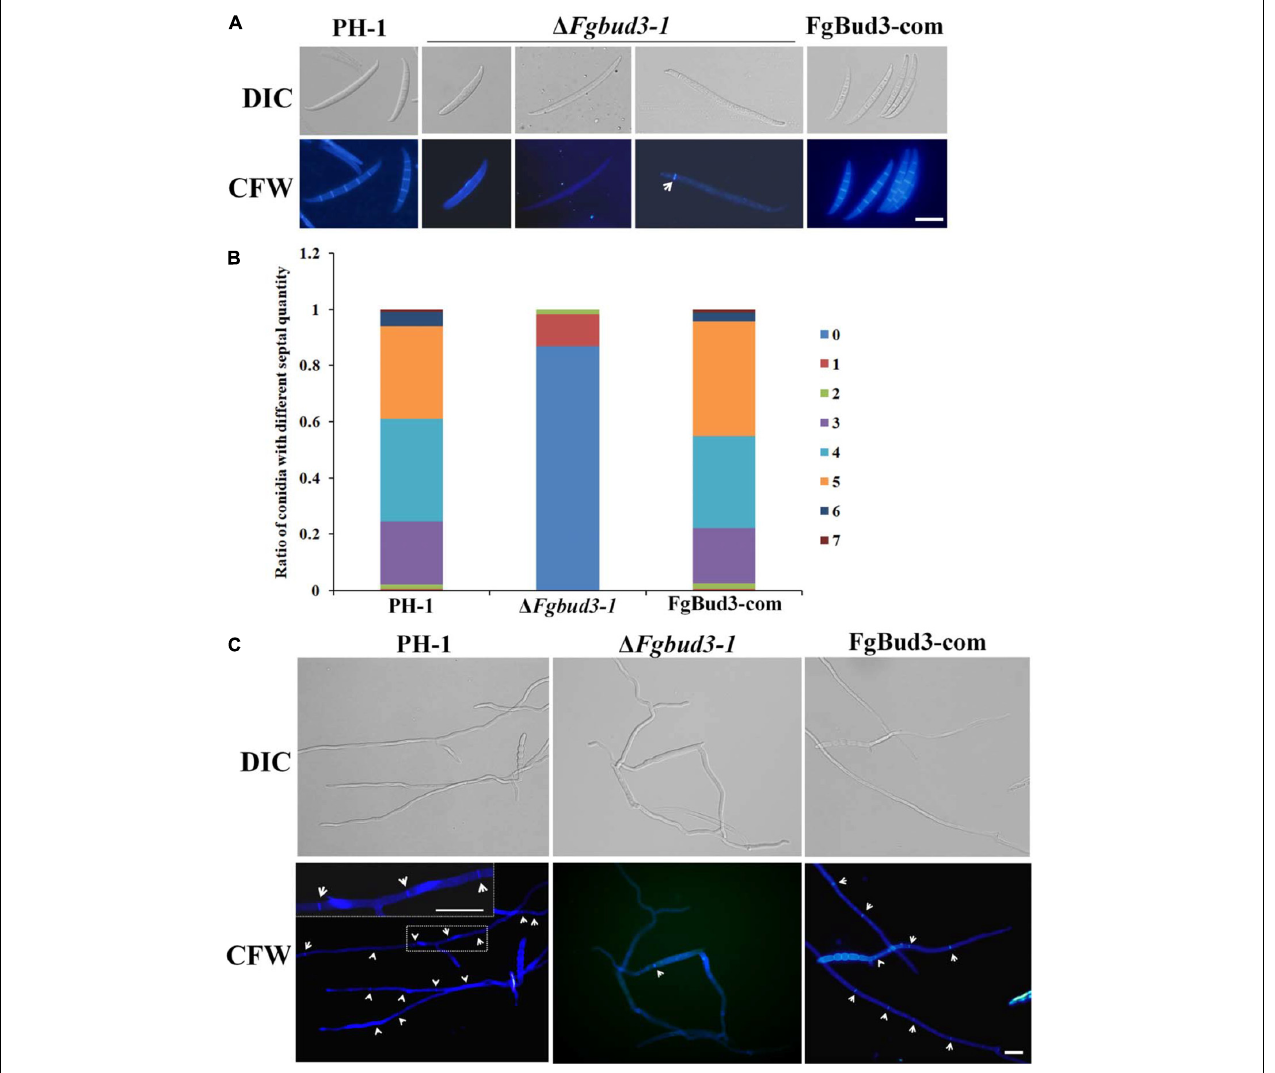
FIGURE 3 | The septum defective phenotype of the FgBUD3 deletion mutant. (A) Conidia of PH-1, (cid:49) Fgbud3-1 and FgBud3-com were stained with 1 µ g/ml CFW and examined by microscopy under DIC or UV light. (B) Ratio of conidia with different septal quantity of each strain. (C) Hypha of each strain were stained and examined. The arrows indicate septa. Bar = 20 µ